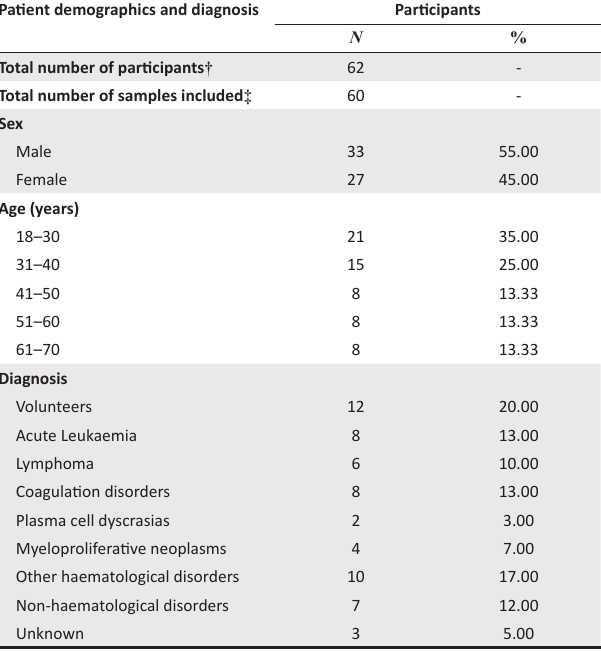
TABLE 1: Demographics and clinical diagnoses of study participants, Inkosi Albert Luthuli Central Hospital and King Edward VIII Hospital, Durban, KwaZulu-